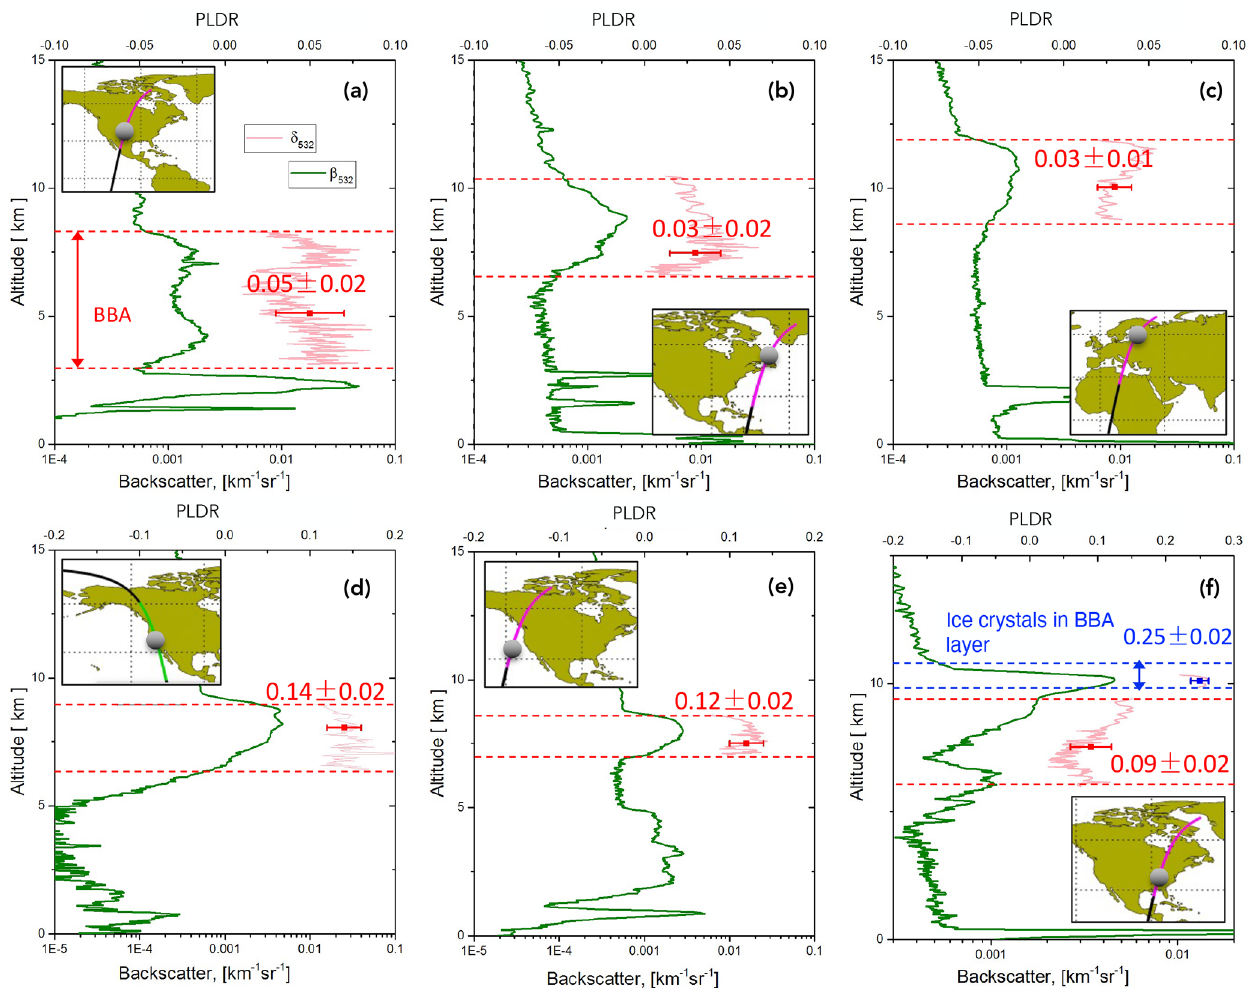
Figure 2. The backscattering coefficients and PLDR ratio at 532nm measured by CALIPSO. The smoke plumes in (a) , (b) and (c) are attributed to the Creek fires from 5 to 7 September 2020, and in (d) , (e) and (f) are attributed to the Oregon fires. The inserted maps display the granules of CALIPSO and the locations of the gray dots represent the region where the measurements are averaged. (a) Central USA,